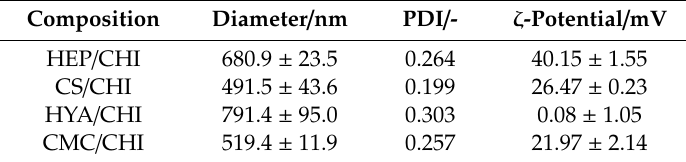
Table 1. Diameter and ζ -potential of PIC particles in PBS (pH 6.9).